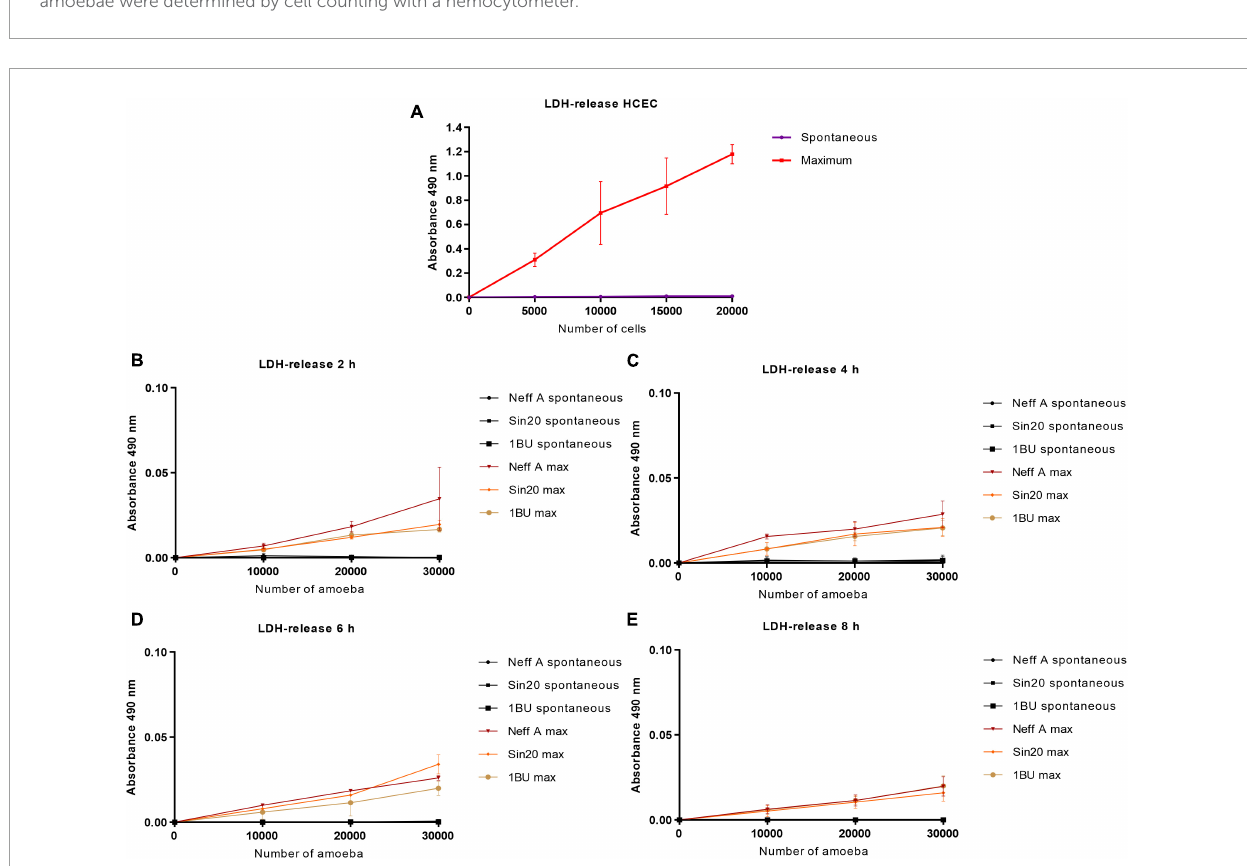
FIGURE2 Effect of HCEC (A) and amoeba (B–E) densities on absorbance at 490 nm by using the LDH release assay, at different times. The background absorbance obtained with the media alone without cells was subtracted from all data. “Maximum” corresponds to the quantity of LDH released into the cell culture medium by lysed or damaged cells, and “Spontaneous” represents the quantity released by living or non-lysed